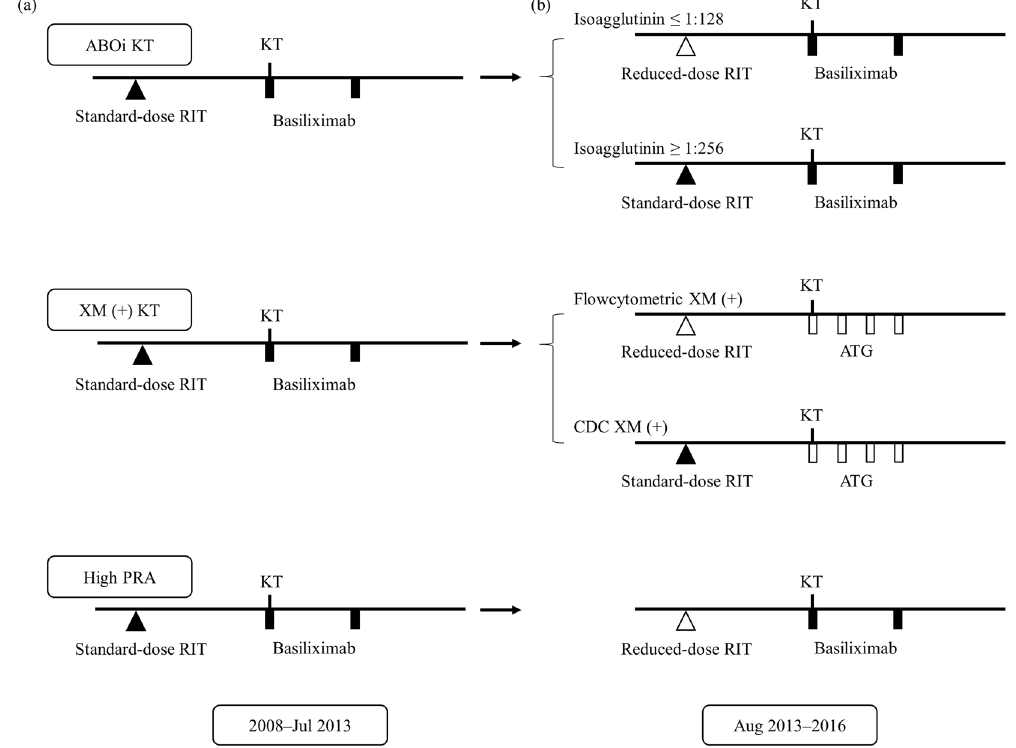
Figure 4. Desensitization protocols for kidney transplantation. ( a ) Desensitization with a standard dose of rituximab (2008–July 2013). ( b ) Modified desensitization with a reduced dose of rituximab (August 2013–